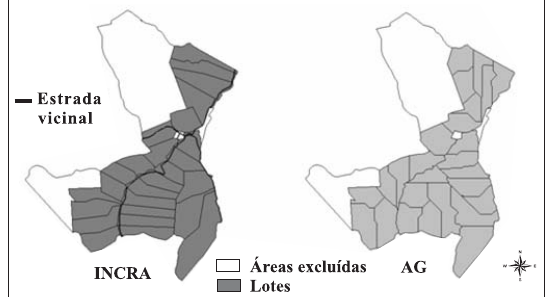
Figura 2. Parcelamento do INCRA e resultado do AG, PA Veredas, Padre Paraíso, MG, 2008. Quadro 2. Fitness e área dos lotes do parcelamento realizado pelo INCRA e do resultado do